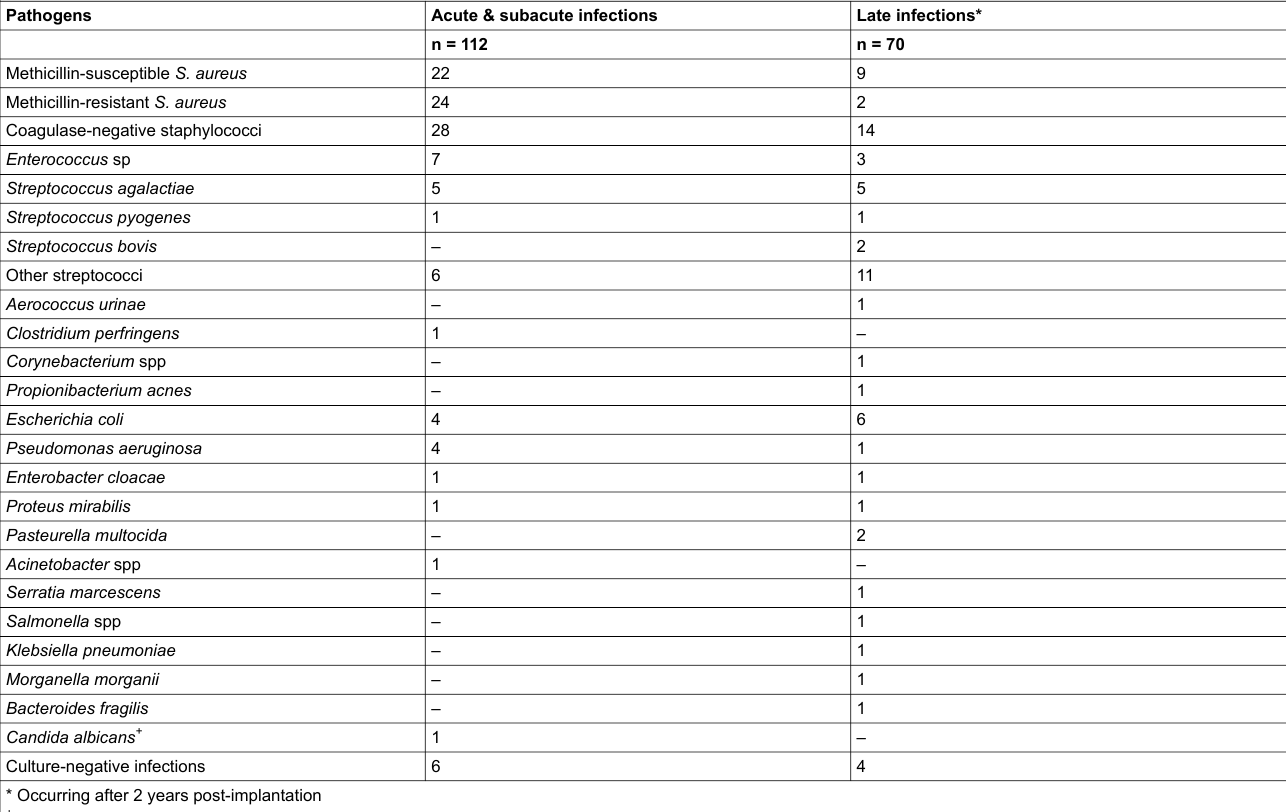
Table 2: Pathogens of arthroplasty infections; above Gram-positives; beneath Gram-negatives.